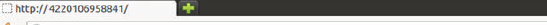
Figure 20: Receiving server response through a web browser.